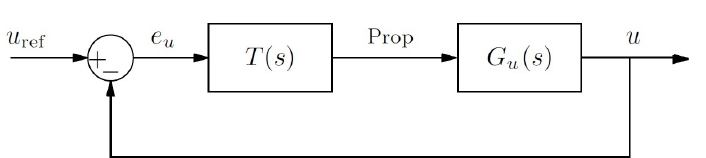
Figure 10. Block diagram of the closed loop system for the velocity control.